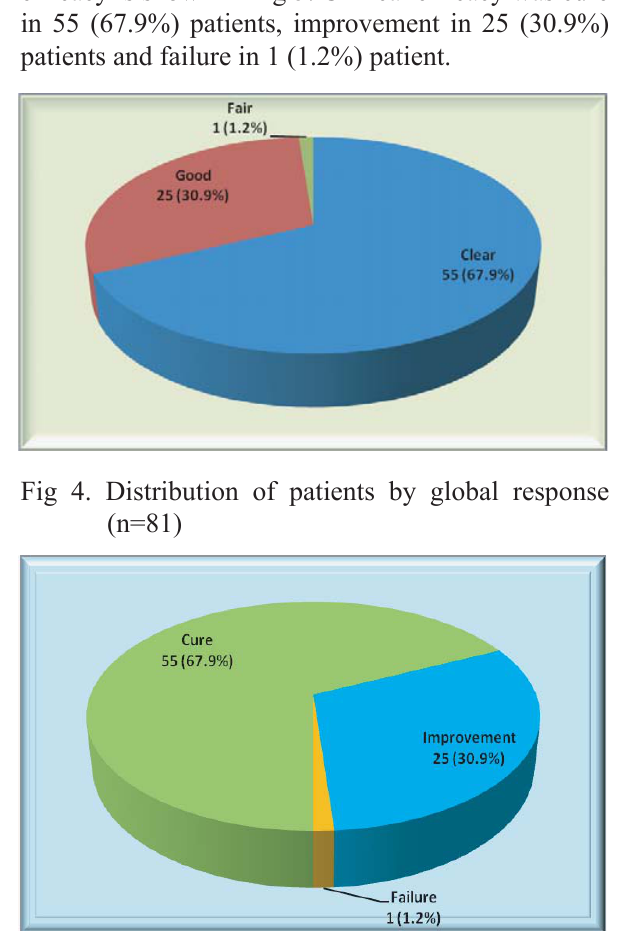
Fig 5. Distribution of patients by clinical efficacy